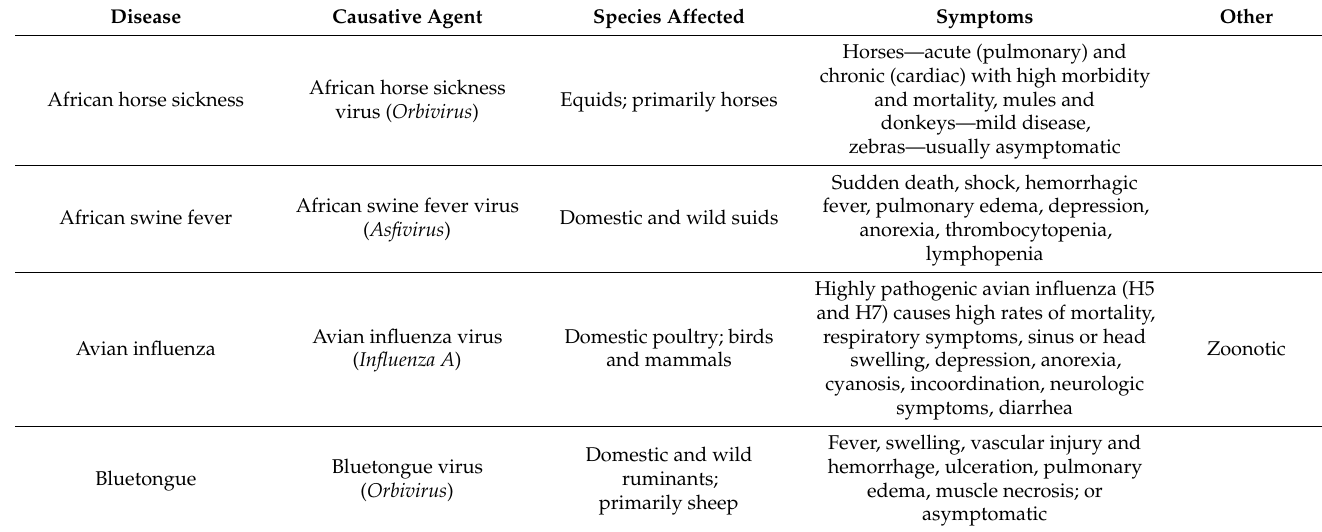
Table 1. Transboundary animal diseases